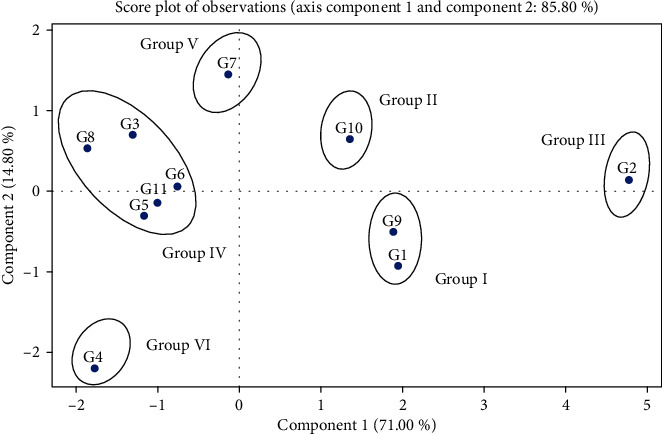
Two-dimensional plot of PCA showing relationships among 12 tossa jute genotypes using six anatomical characters attributing to fiber.